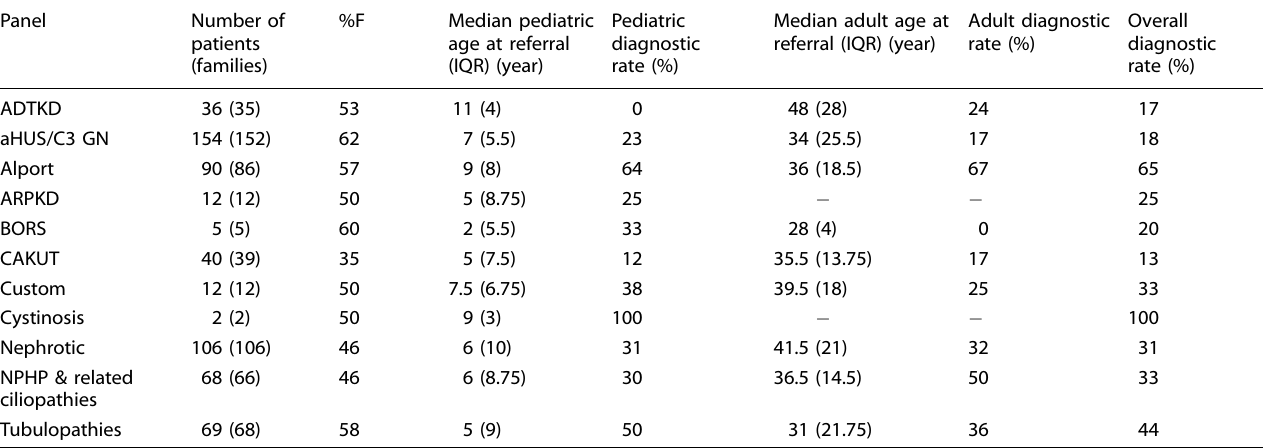
Table 1. Summary of demographic and diagnostic results of the 542 families in Australia and New Zealand strati fi ed by panel.